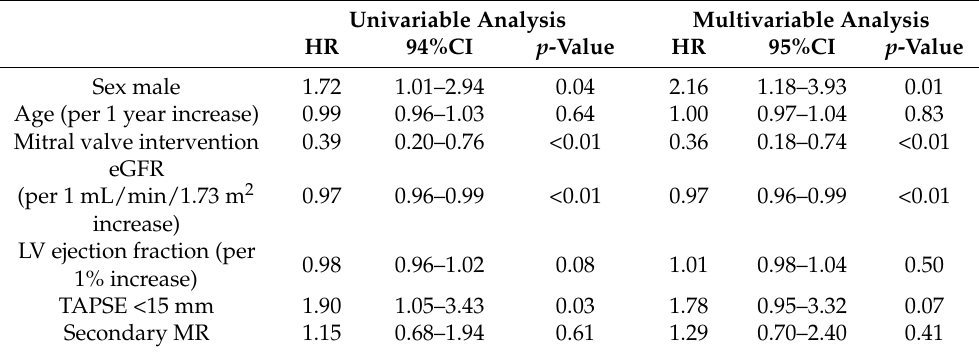
Figure 6. Heart failure rehospitalization and all-cause mortality within one year. The Kaplan–Meier curve depicts a lower cumulative event rate of heart failure rehospitalization in patients undergoing mitral valve interventions compared to patients treated with medical therapy (18.2% vs. 42.0%, p < 0.01) ( a ). In contrast, one-year all-cause mortality was similar between the groups (20.2% vs. 22.6%, p = 0.71) ( b ). Table 5. Association of mitral valve intervention with one-year heart failure rehospitalization.